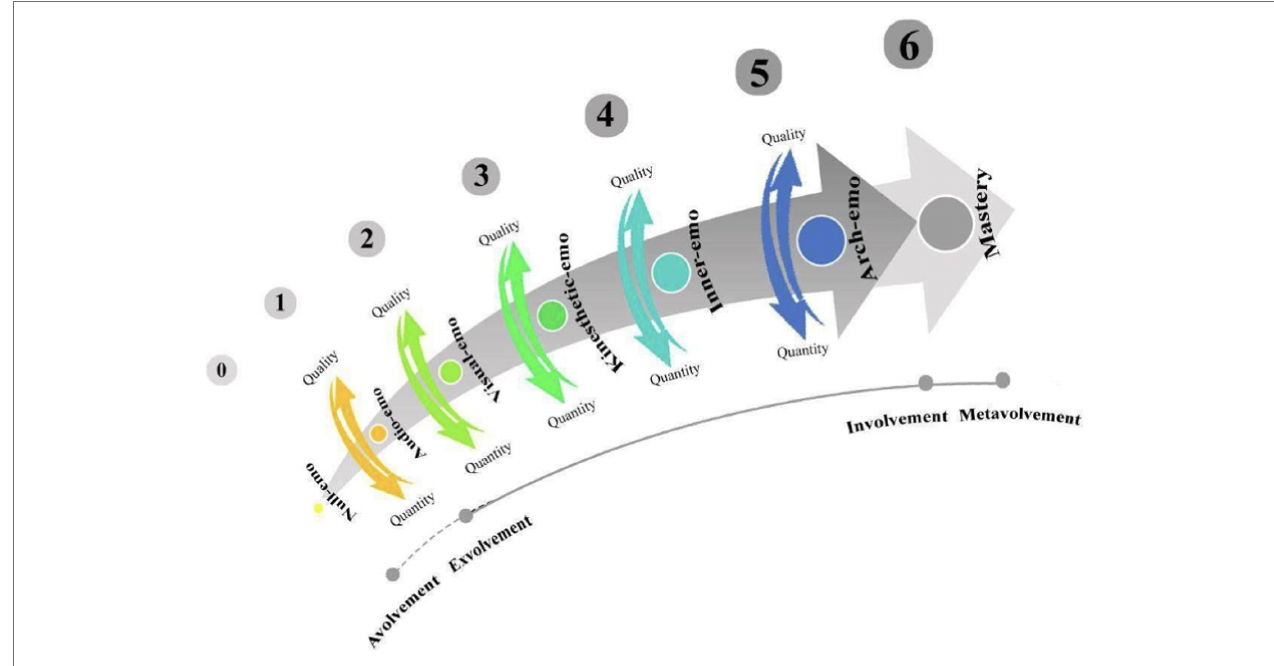
FIGURE 2 | Emotioncy